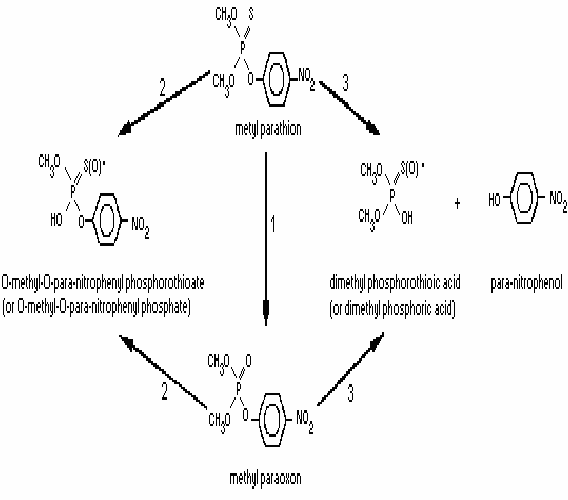
Figure 4: Metabolic pathways of methyl parathion